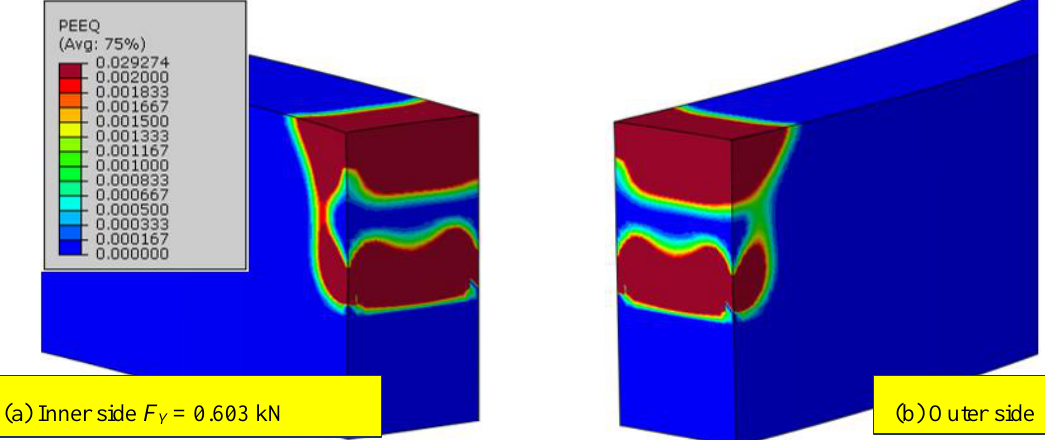
Figure 8. The equivalent deformation of ( a ) on the inner side with meeting the criterion of the limit load and ( b ) on the outer side, where the theoretical limit load criterion is not yet met for the ratio R / B = 20 at 2.15 mm.